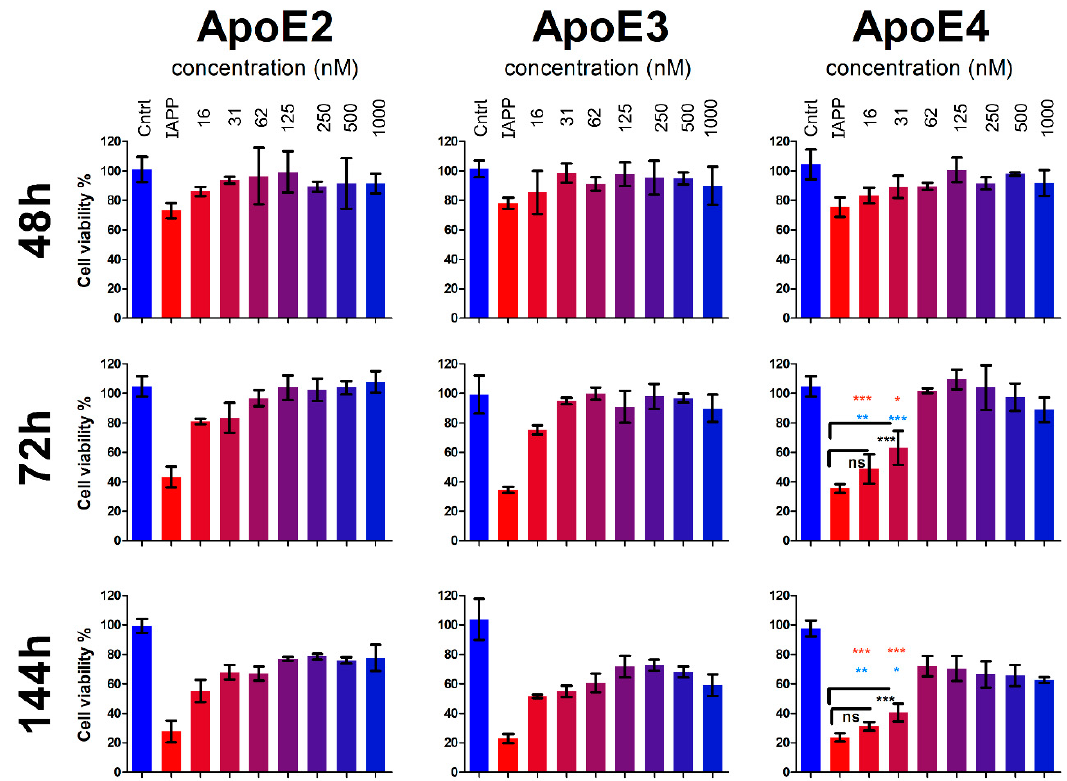
Figure 4. Influence of ApoEs on IAPP-induced cytotoxicity in human blood vessel pericytes. The viability of the cells treated with 10 µ M IAPP alone or in combination with ApoE variants in the concentration range 1 µ M–16 nM was analyzed after 48, 72, and 144 h of co-incubation with the cells. Control cells represent the samples treated with 1 µ M ApoE only. The percentage of the viability is calculated based on untreated cells having 100% viability. The key statistical values are presented on the graphs. p < 0.05 (*); p < 0.01 (**); p < 0.001 (***). Red and blue colored asterisks represent comparison with ApoE2 and ApoE3, respectively.